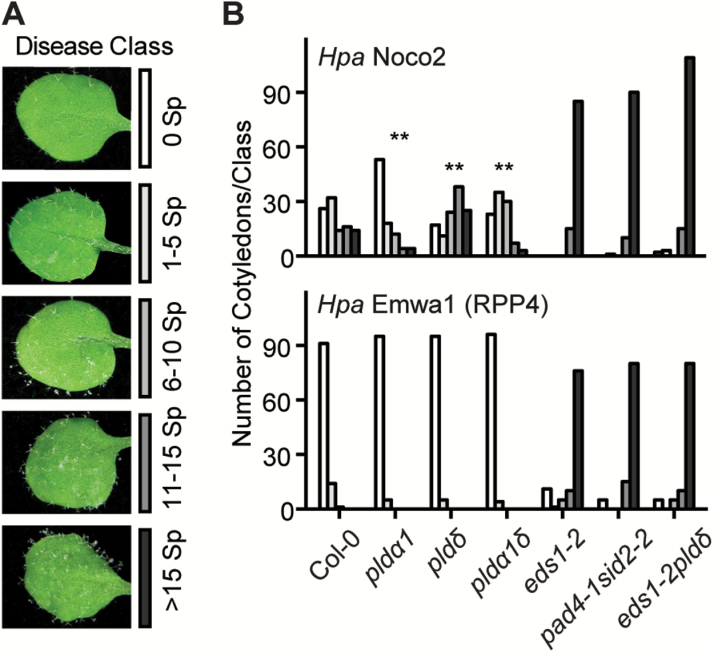
Loss of PLDα1 and/or PLDδ affects basal resistance against oomycetes, but not ETI mediated by RPP4. (A) Representative cotyledons showing disease phenotypes of the indicated disease classes at 7 dpi. Ten-day-old seedlings were inoculated with virulent Hyaloperonospora arabidopsidis (Hpa) isolate Noco2 or avirulent isolate Emwa1. Sporangiophores (Sp) per cotyledon were assessed at 7 dpi, and categorized into five classes as indicated by the corresponding figure keys. (B) Quantification of the number of cotyledons (n >100 for each of the indicated genotypes) per class of the indicated genotypes infected with Hpa isolate Noco2 (upper panel) or avirulent isolate Emwa1 (lower panel) based on categorization of leaf infection defined in (A). χ2 test was used to test statistical significance for disease degree between Col-0 and the indicated mutant lines at 7 dpi (**P<0.01).